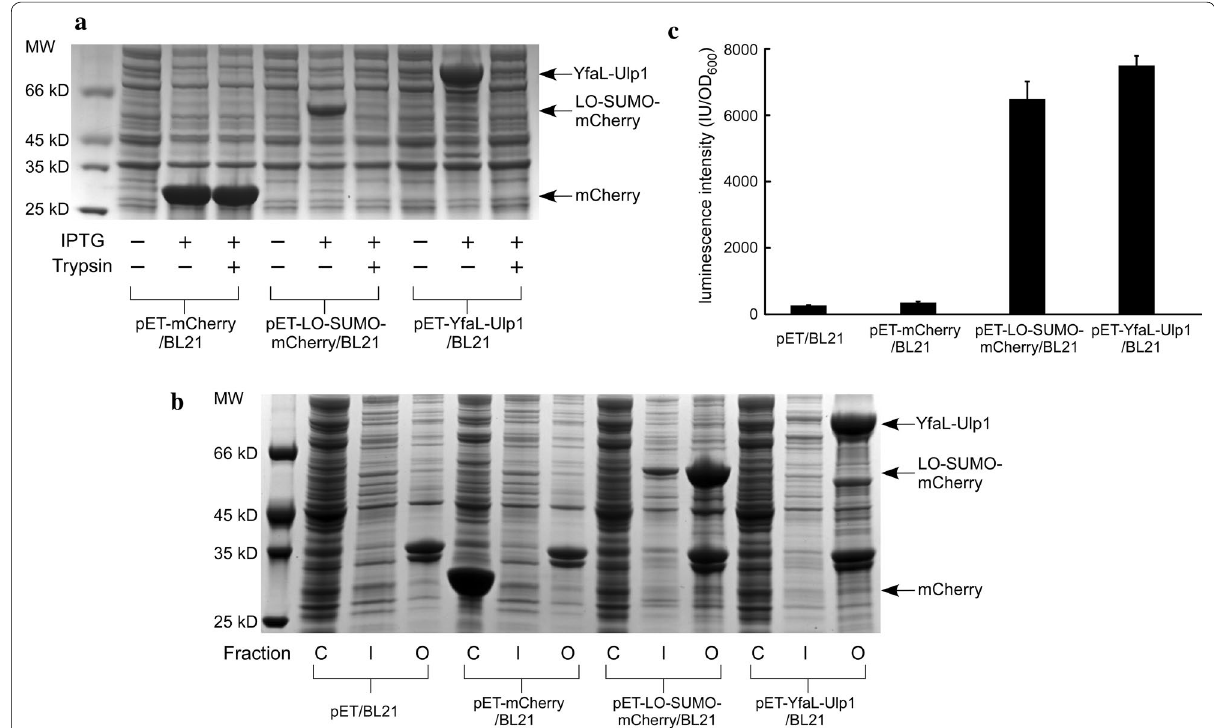
Fig. 3 a SDS‑PAGE analysis of the expression of surface‑displayed SUMO‑mCherry and Ulp1 induced by IPTG and the induced cells after incubation in the presence of 200 μg/mL trypsin at 37 °C for 1 h. b Protein expression in different fractions of induced cells. Equal volumes of fractionated samples were used for SDS‑PAGE analyses. C: cytoplasmic fraction; I: inner membrane fraction; O: outer membrane fraction. The results are representative of three independent experiments. c Immunolabeling analysis of induced intact cells using anti‑His antibody. After three washes to remove unbound secondary antibody, the cells were incubated in ECL substrate solution for 10 min to develop the chemiluminescence. The luminescence intensity was measured at 425 nm using a microplate reader. Data are means of three independent experiments, error bars